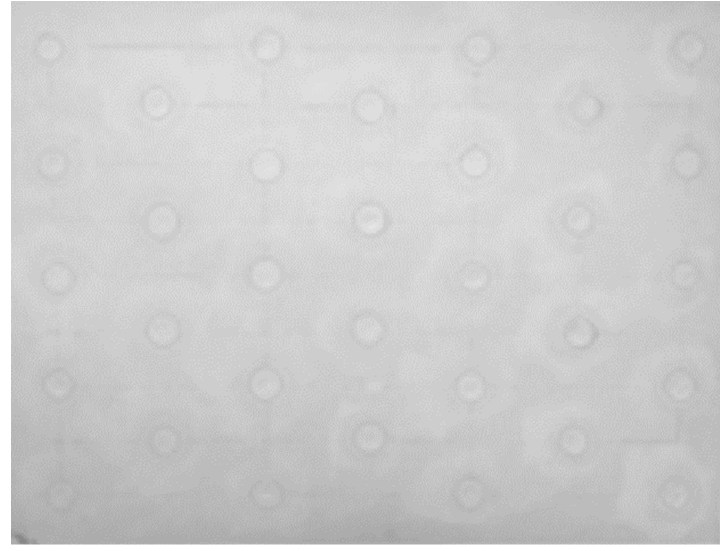
Figure 8. The sample analyzed: Rear side.